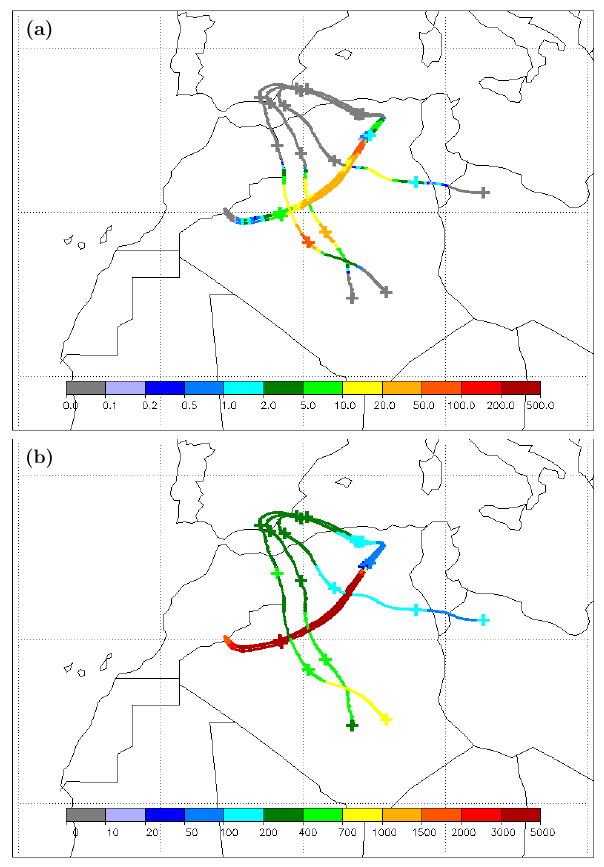
Fig. 7. Eight-day backward trajectories initialised on 3 June 2006 00:00UTC starting from the three lowest model layers at Tinfou. A “+” is drawn every 24h. Coloured variables along the trajectories are (a) the dust emission (µgm − 2 s − 1 ) and (b) the dust concentra- tion (µg m − 3 ).